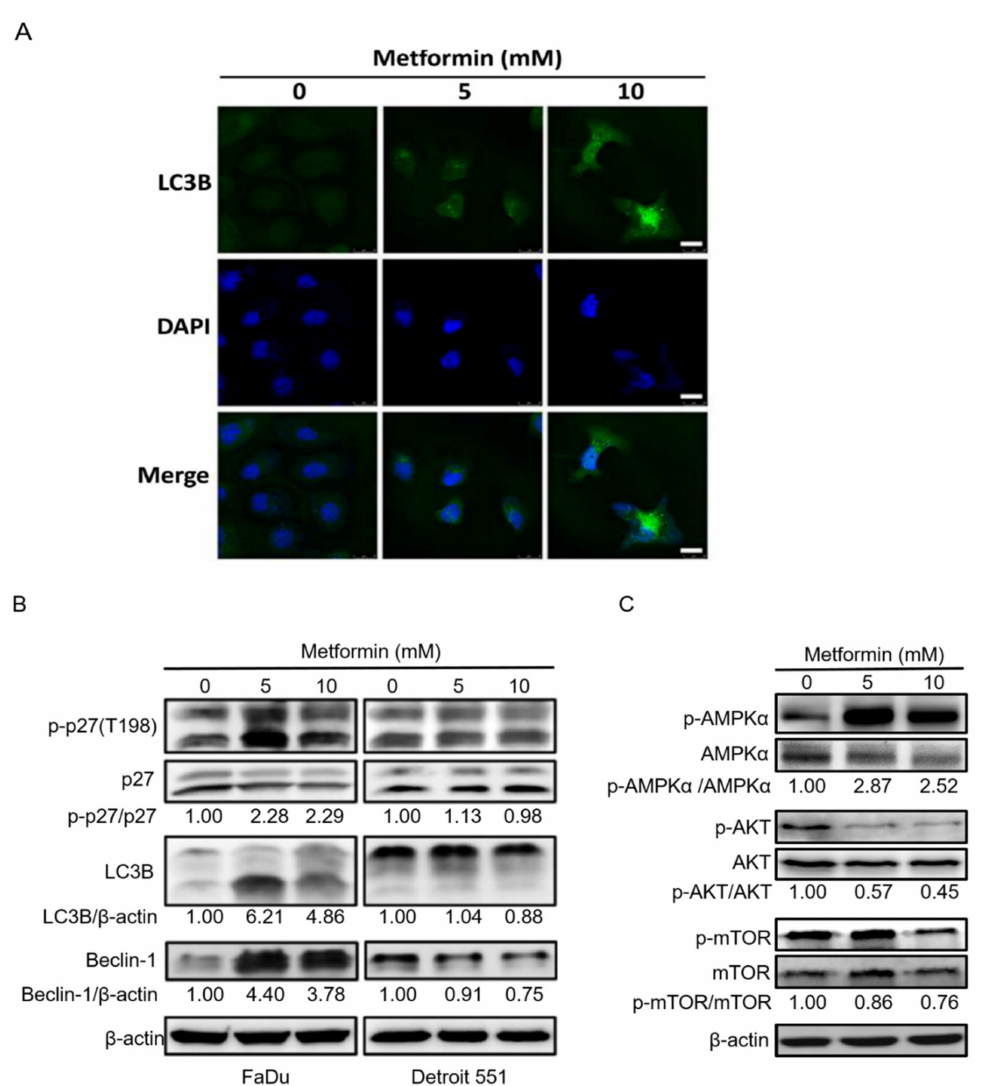
Figure 5. Metformin induced autophagy in hypopharyngeal cancer cells. ( A ) Metformin increased LC3B expression. FaDu cells were treated with 0, 5, and 10 mM metformin for 48 h. The endogenous LC3B expression was assessed by confocal microscopy after staining with anti-LC3B antibodies (green) and 4 (cid:48) ,6-diamidino-2-phenylindole (DAPI) (blue). Scale bars, 25 µ m. ( B ) Metformin upregulated p27(Thr198) phosphorylation and expression of LC3B and Beclin-1. FaDu and Detroit 551 cells were treated with 0, 5, 10 mM metformin for 48 h. Cell lysates were separated by SDS-PAGE and analyzed by Western blot with the indicated antibodies. ( C ) Metformin reduced mTOR phosphorylation via AMPK α phosphorylation in hypopharyngeal cancer cells. FaDu cells were treated with 0, 5, and 10 mM metformin for 48 h. Cell lysates were separated by SDS-PAGE and analyzed by Western blot